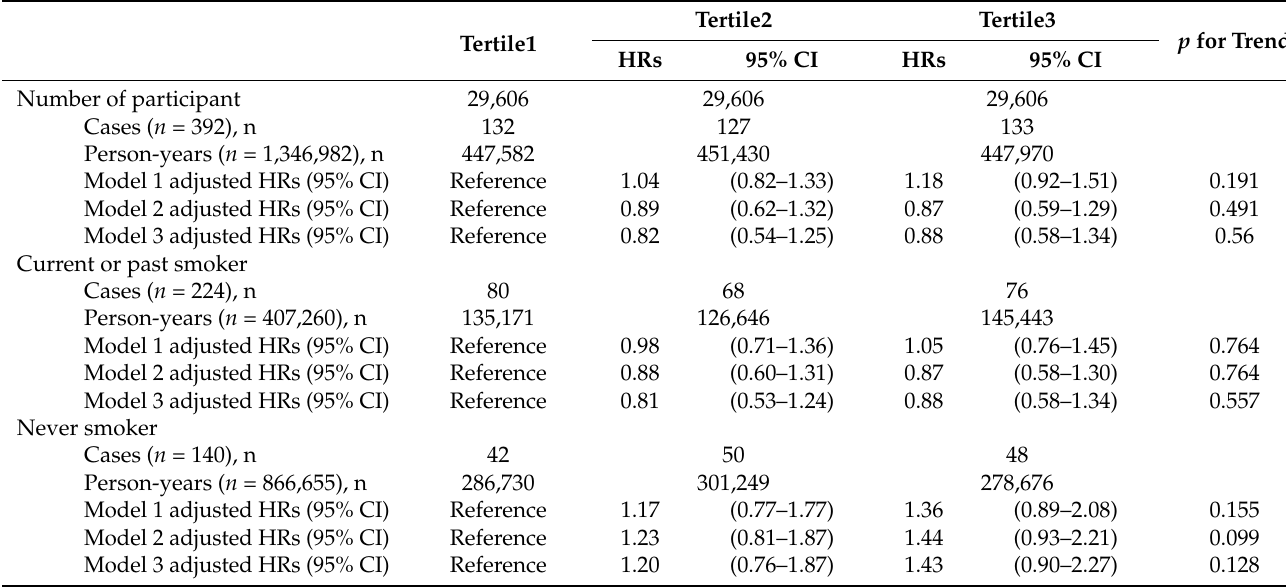
Table 4. Acrylamide intake and the risk of bladder